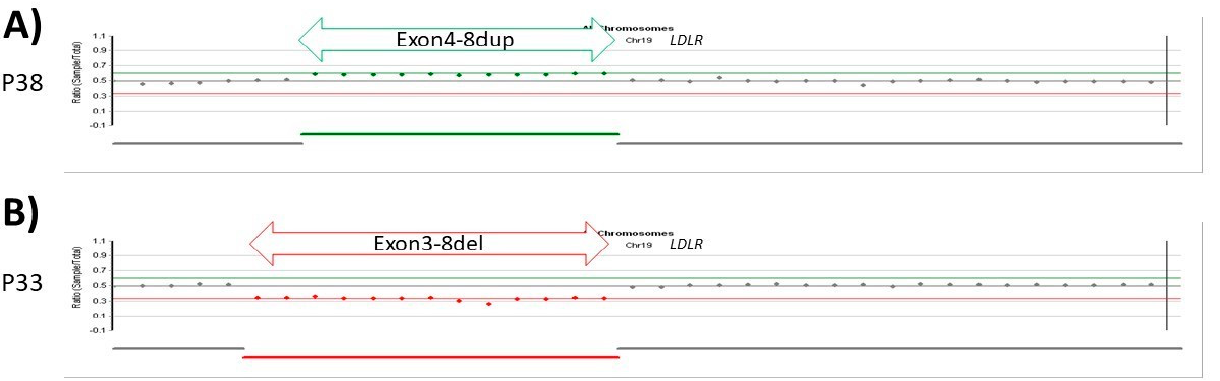
Figure 4. Coverage-based CNV detection in the LDLR gene. ( A ) In patient 38, the duplication of exons 4–8 was detected based on coverage data. The green arrow indicates the location and size of the duplication. ( B ) In patient 33, the deletion of exons 3–8 was detected based on coverage data. The red arrow indicates the location and size of the deletion.